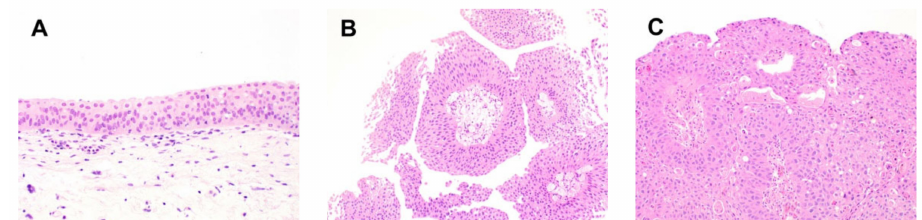
Figure 1. Histology of urothelium. ( A ) Normal urothelium is a polarized epithelial lining containing urothelial cells and surface umbrella cells; the urothelial lining is polarized, with a relatively uniform nuclear size, open chromatin, and limited to rare mitotic figures (200 × ). ( B ) Low-grade papillary urothelial carcinoma is a papillary neoplasm with thin fibrovascular cores lined by relatively polarized urothelium containing occasional hyperchromatic nuclei (100 × ). ( C ) High-grade papillary urothelial carcinoma, another papillary neoplasm, shows cellular disorganization and enlarged hyperchromatic nuclei with nuclear pleomorphism and abnormal localization of mitotic figures (100 ×